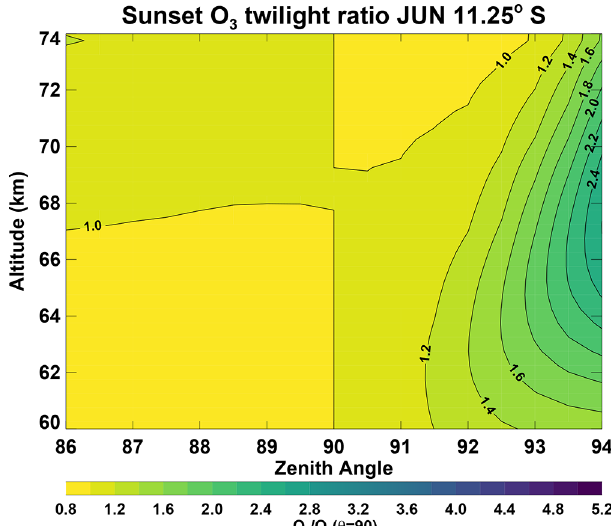
Figure 5. Ozone twilight ratio, defined as O 3 at solar zenith angle θ/ O 3 at θ = 90 ◦ , as a function of SZA and altitude for sunset in June and 11.25 ◦ S